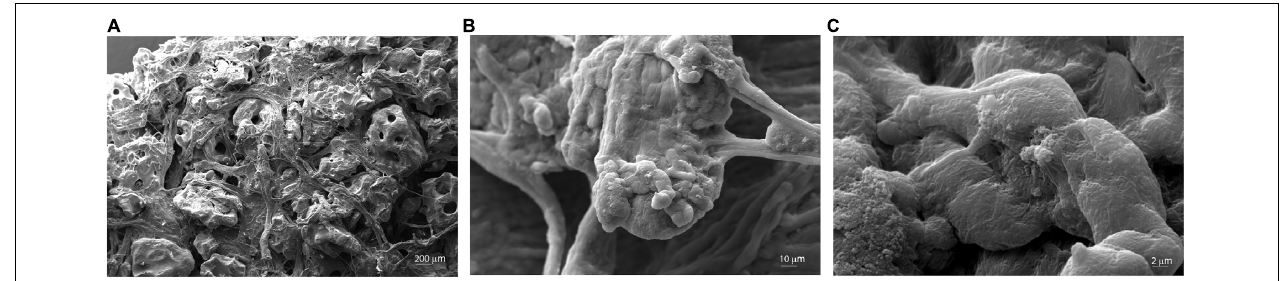
FIGURE 2 | Scanning electron microscopy (SEM) analysis of the Coll/Pro Osteon R (cid:13) 200. (A) Coll/Pro Osteon R (cid:13) 200 shows the porous structure with several pores within a range of 190–230 µ m, magnification 77 × . (B,C) Organization and structure of collagen fibrils bovine from AviteneTM Microfibrillar Collagen Hemostat (Bard Warwick, RI, United States) visualized on Coll/Pro Osteon R (cid:13) 200. Collagen fibrils randomly organized are present as fibril interweaving insert maintained the porous structure (2.01KX; 10.73KX).